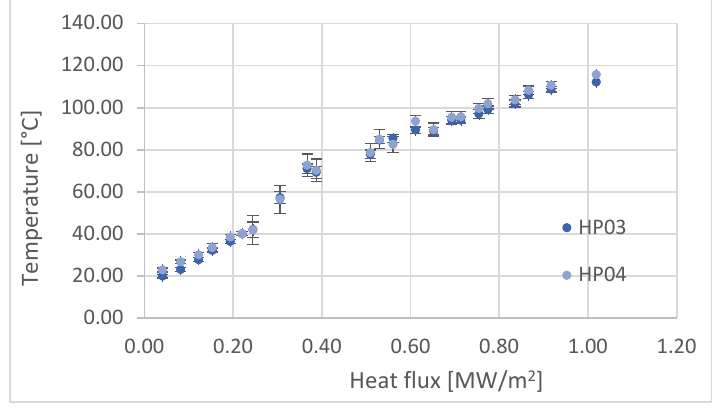
Figure 15. Vapor temperature of mock-up-1(heated by laser power) as a function of the heat flux.